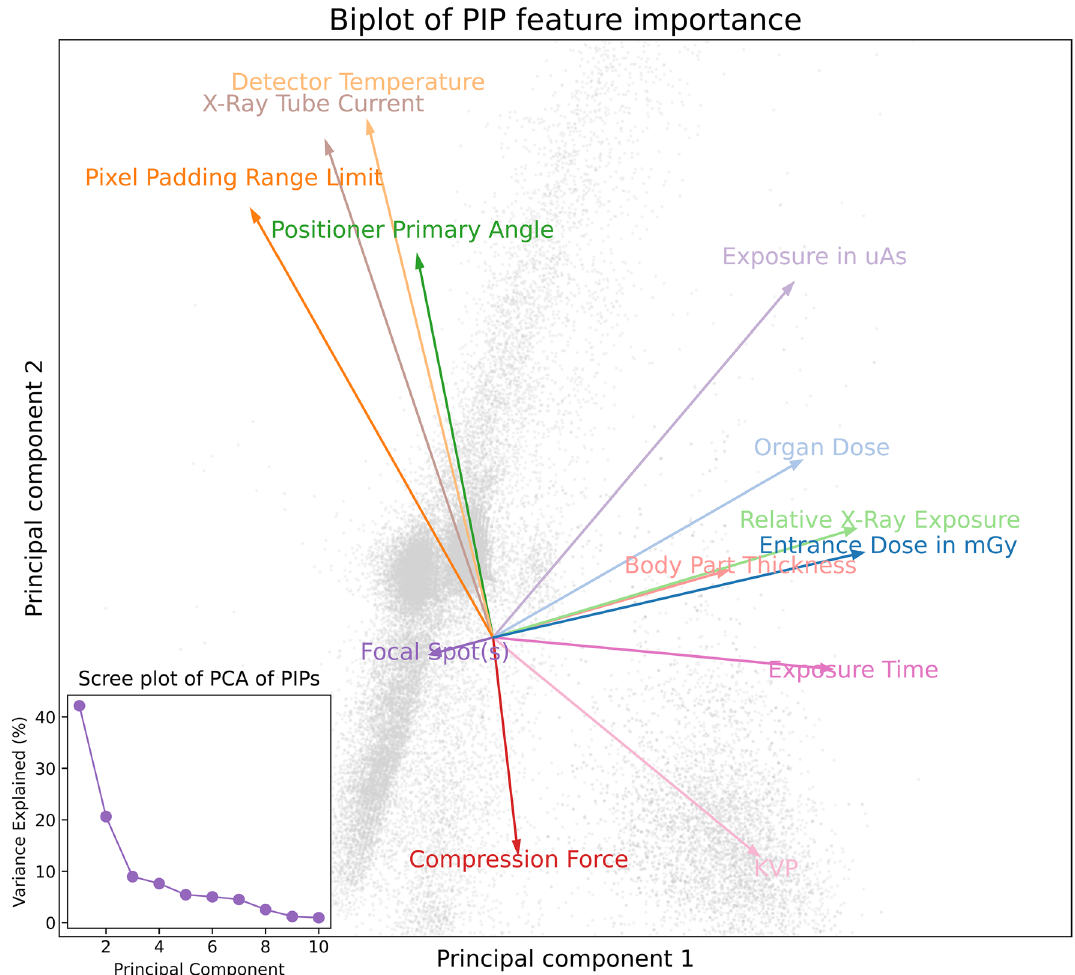
Figure 7. Biplot of each feature projected into the PCA space. Longer vectors indicate more significance on domain shift and angle of each vector is proportional to its influence on one of the first 2 principle components. Subplot shows a Scree plot to outline variance each principle component accounts